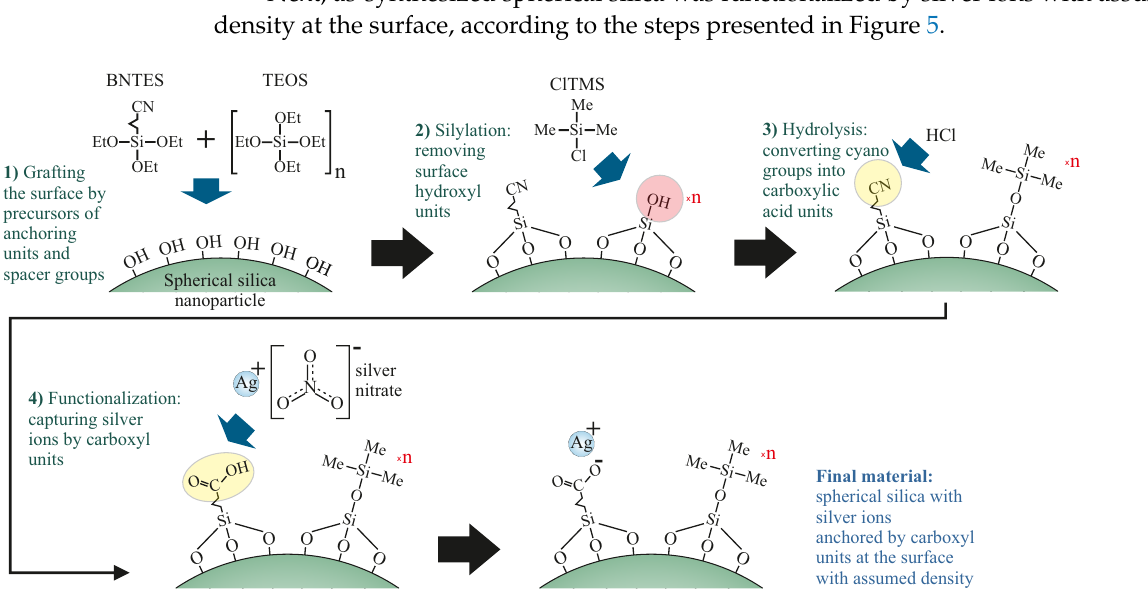
Figure 5. A diagram of the synthesis route of the spherical silica functionalized by silver ions anchored by propyl carboxylic acid groups with an assumed distribution. The number “n” denotes the number of tetraethyl orthosilicate (TEOS) in moles per single mole of the precursor of functional units (butyronitriletriethoxysilane—BNTES) and determines the density. Other abbreviations: TEOS— tetraethyl orthosilicate, ClTMS—chlorotrimethylsilane, Me—methyl groups, Et—ethyl